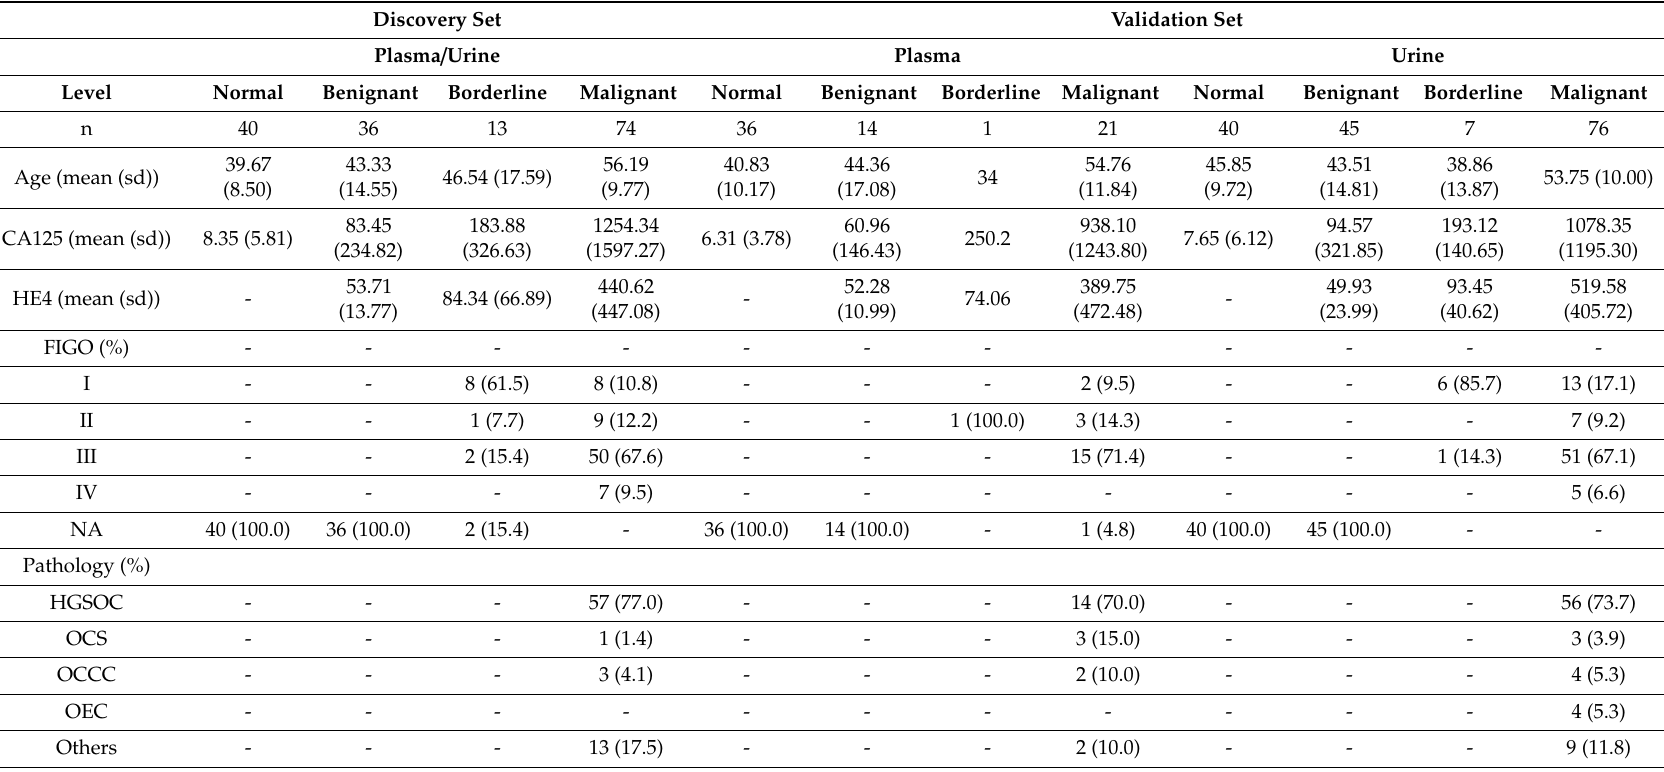
Table 1. Clinic characteristics of the samples in each